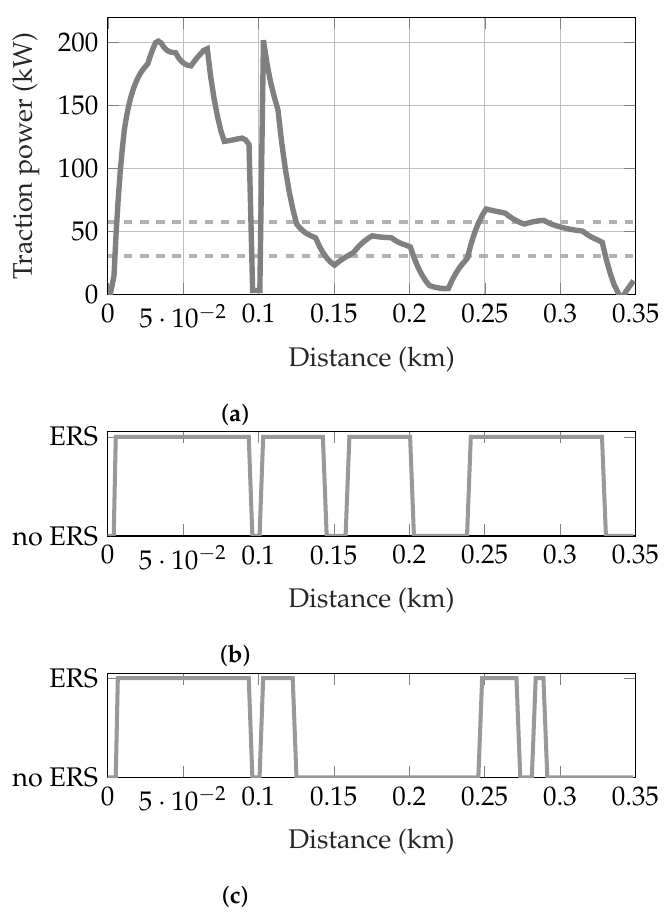
Figure 9. Traction power dependent ERS placing, ADA, procedure illustrated. ( a ) shows the required traction power (solid line) and two different levels of constant power threshold (dashed lines). ( b , c ) each show the ERS placement according to the lower and higher power threshold, respectively.